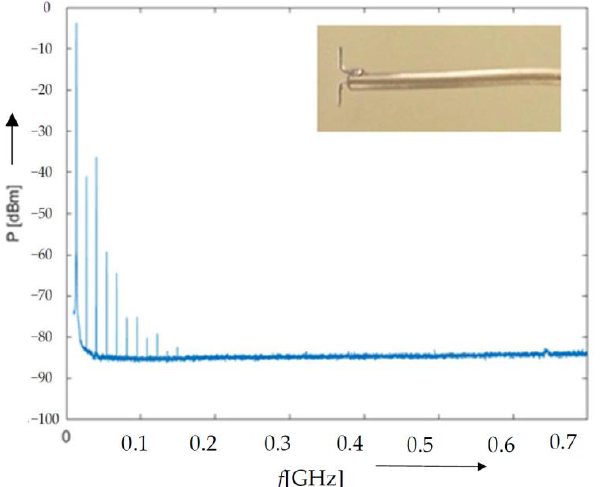
Figure 10. The measured frequency spectrum of the electromagnetic field irradiated by the plasma. The parameters and conditions included P out = 50 W, f g = 13.56 MHz, argon flow rate of v v = 5 L/min, contact between the plasma and the duralumin basis, jet orifice at the height of l = 10 mm, and frequency spectrum sensing accumulation of 50× ( f max = 0.7 GHz). Table 2. The graphically displayed results of the numerical models (A—Figure 7a, B—Figure 7b, C—Figure 7c) and the experimental antenna measurements (D—Figure 9, E—Figure